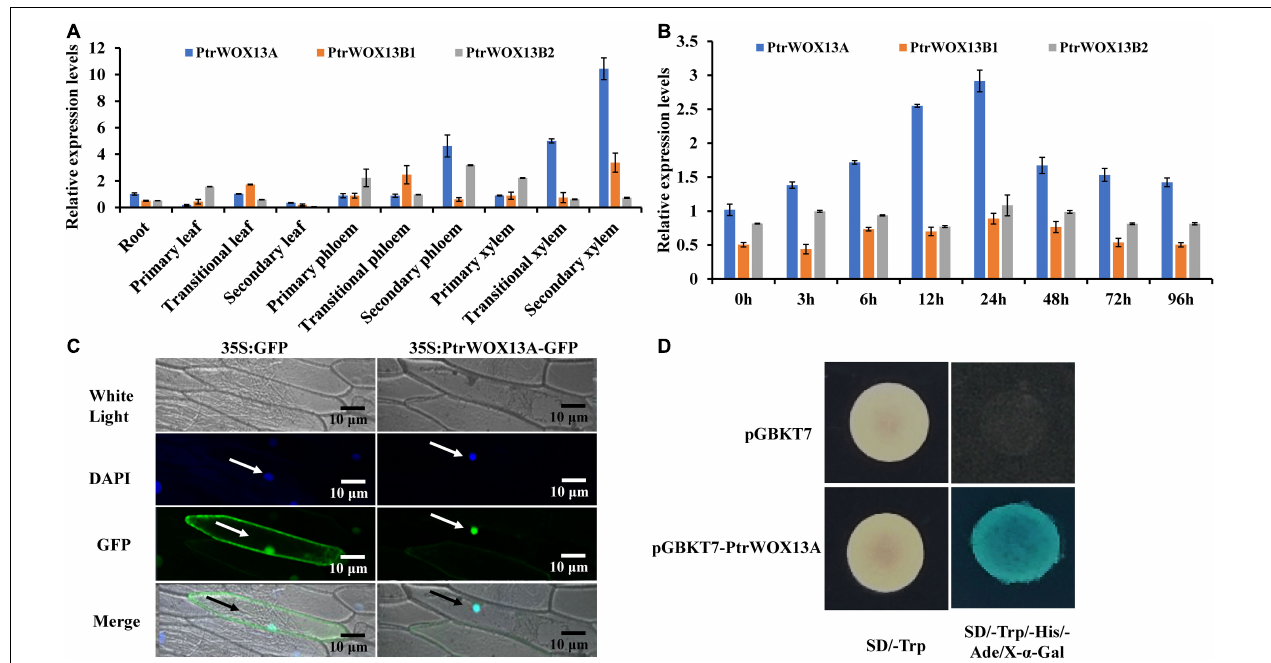
FIGURE 1 | Tissue-specific expression patterns, subcellular localization, and transcriptional activity of PtrWOX13A . (A) The tissue-specific expression patterns of three PtrWOX13 genes as determined by qRT-PCR analysis. PtrActin was used as a reference gene. The expression of PtrWOX13A in root was set to 1 and expression in all other tissues is relative to roots. (B) The temporal expression patterns of three PtrWOX13 genes after GA treatments as determined by qRT-PCR analysis. PtrActin was used as a reference gene. The expression of PtrWOX13A at 0 h was set to 1, all other time points were relative to 0 h. (C) Subcellular localization of PtrWOX13A. Confocal images manifested the localization of PtrWOX13A: DAPI, a nuclear staining dye; GFP proteins in the nuclei of onion epidermal cells. Merge: The merged images of White light, DAPI, and GFP staining. Arrows indicate cells located in the epidermis of onions. (D) Transcriptional activation analysis of PtrWOX13A fused with the GAL4 DNA binding domain (GAL4DB) in yeast showed its potential to activate the expression of the His-3 and X- α -Gal reporter genes.